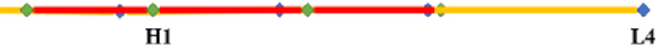
Figure 7. Beam element model established by LMS (L1, L2, L3 and L4 are low-pressure rotor meas- uring points, H1 is high-pressure rotor measuring points, yellow line is low-pressure rotor, red line is high-pressure rotor).